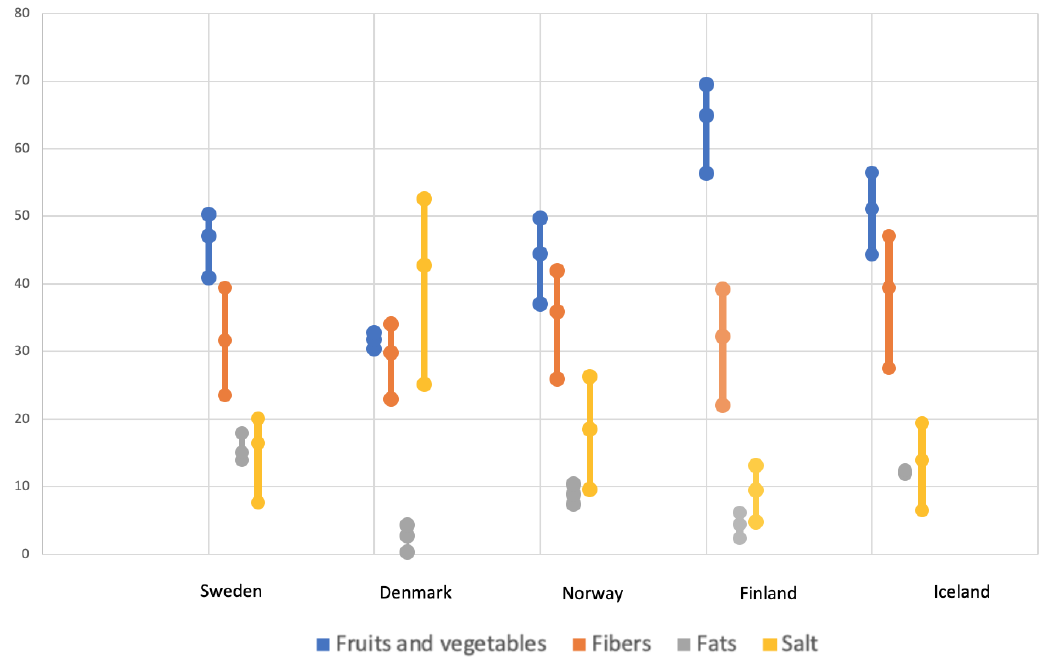
Figure 1. Percentage of deaths (together with a 95% Uncertainty Intervals) delayed or saved by dietary changes in a year in the Nordic Countries.